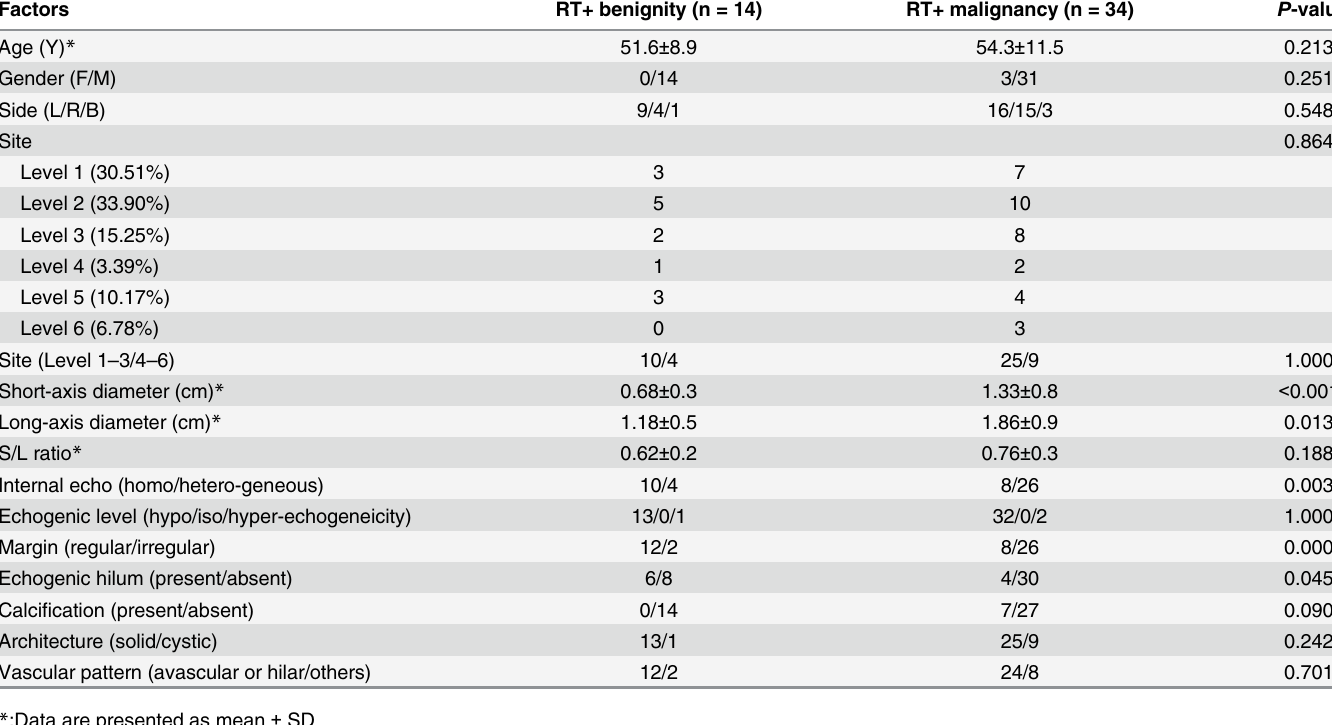
Table 3. A comparison of demographic features between benignity and malignancy in treated OSCC patients with previous neck RT (RT+).